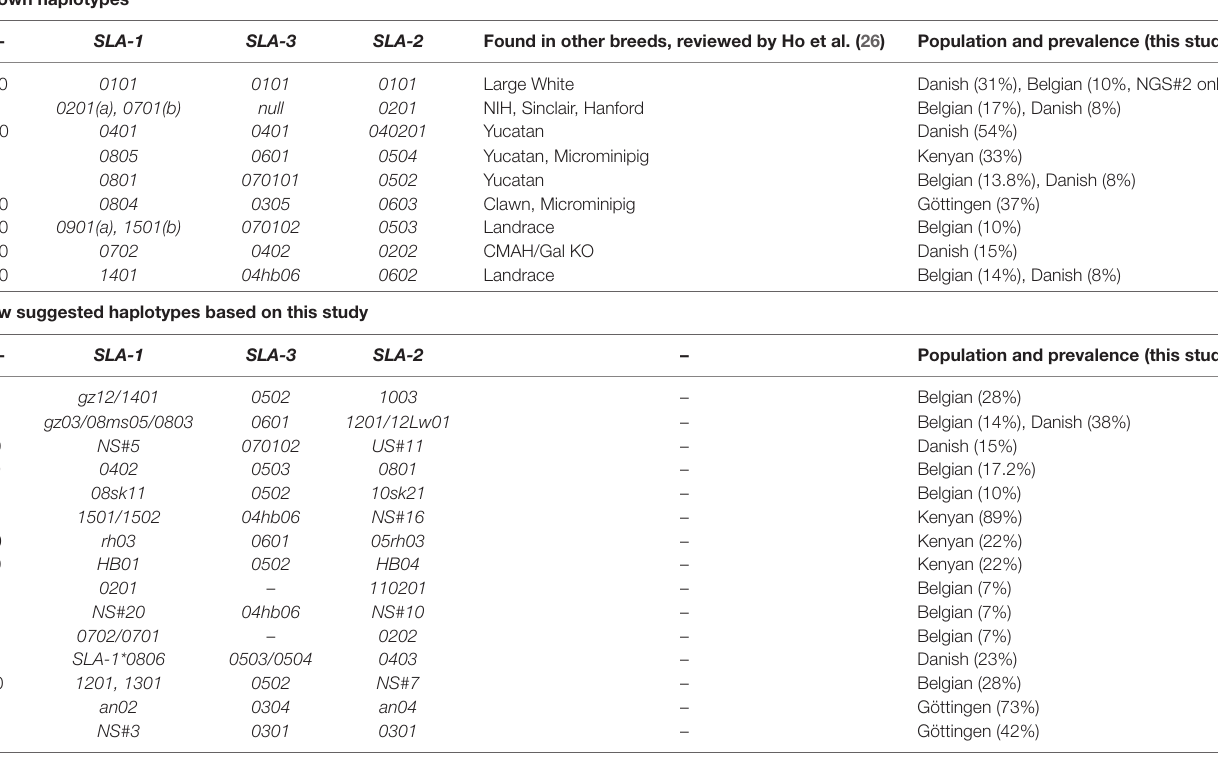
TaBle 3 | Novel SLA class I sequences.